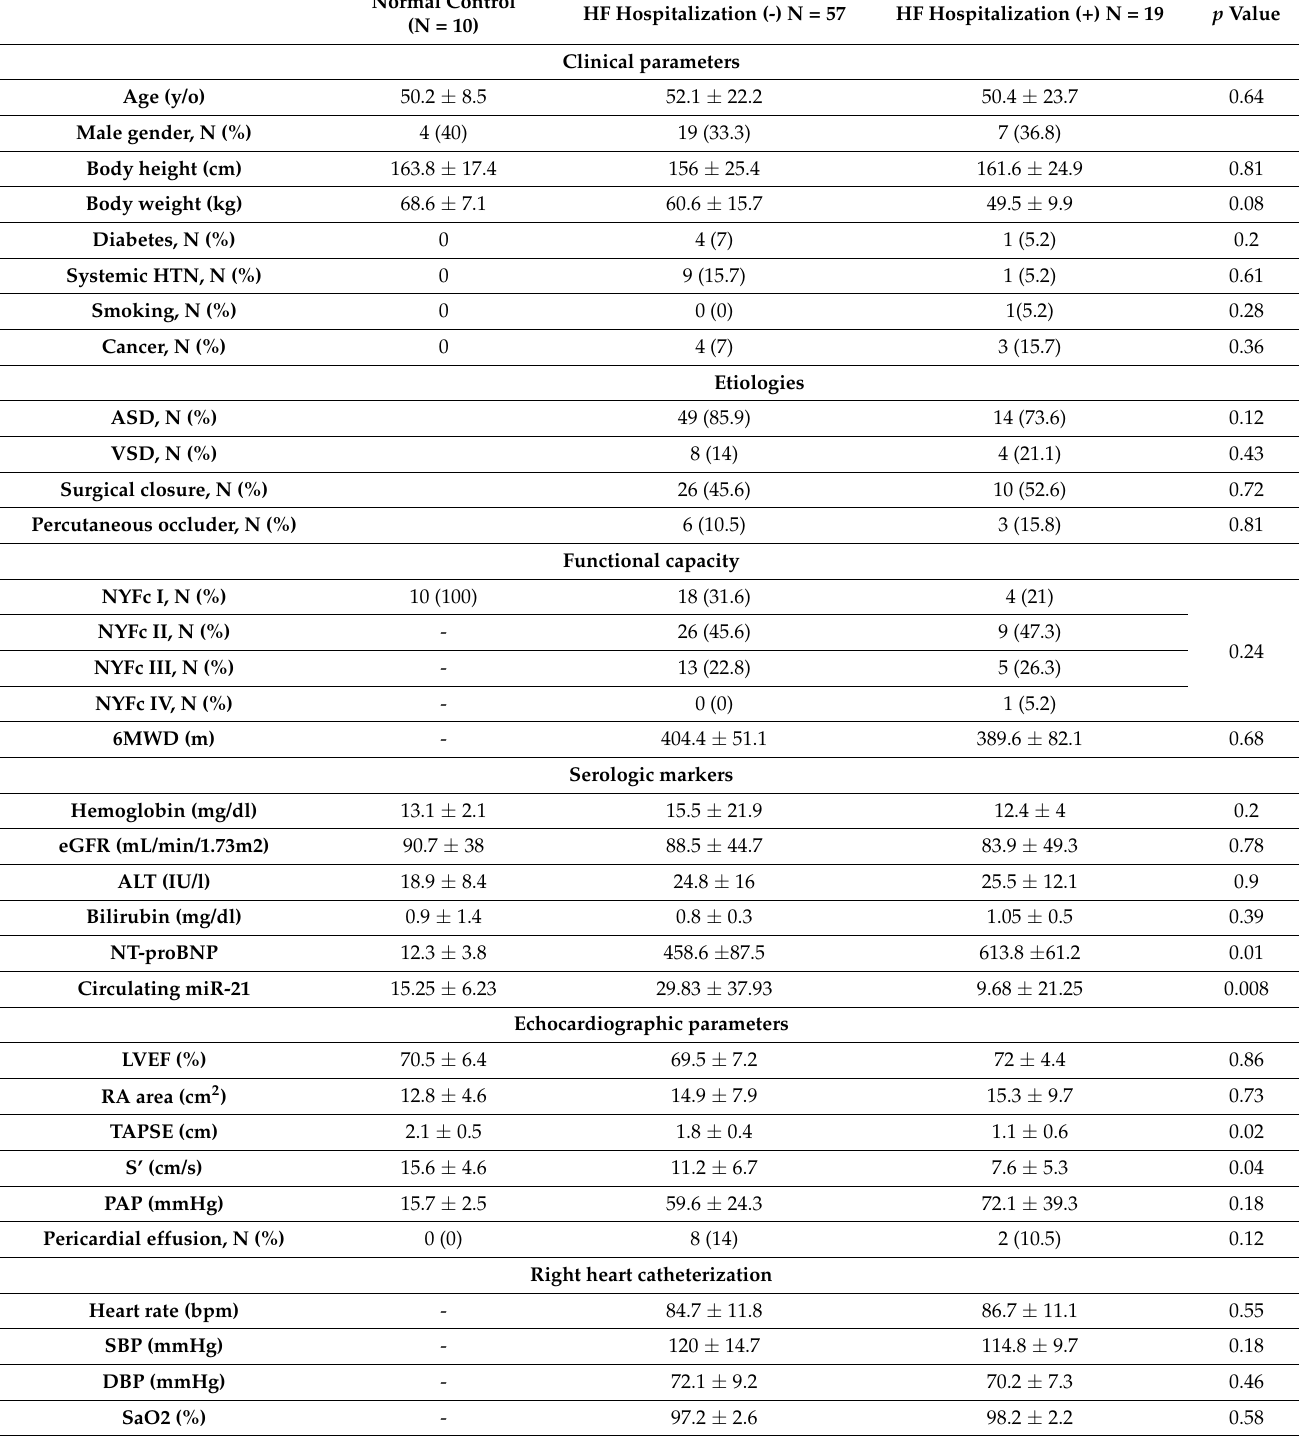
Table 1. The baseline clinical, echocardiographic, functional, hemodynamic and serologic parameters of patients with congenital heart disease-(CHD) related pulmonary arterial hypertension